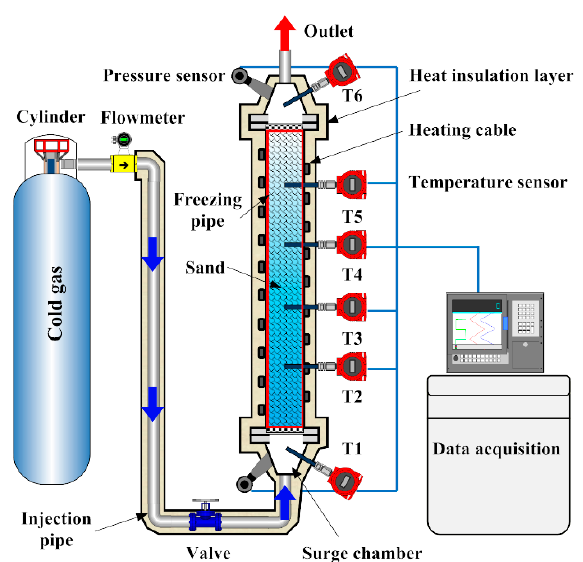
Figure 2. Principle diagram of freezing model and experimental device.